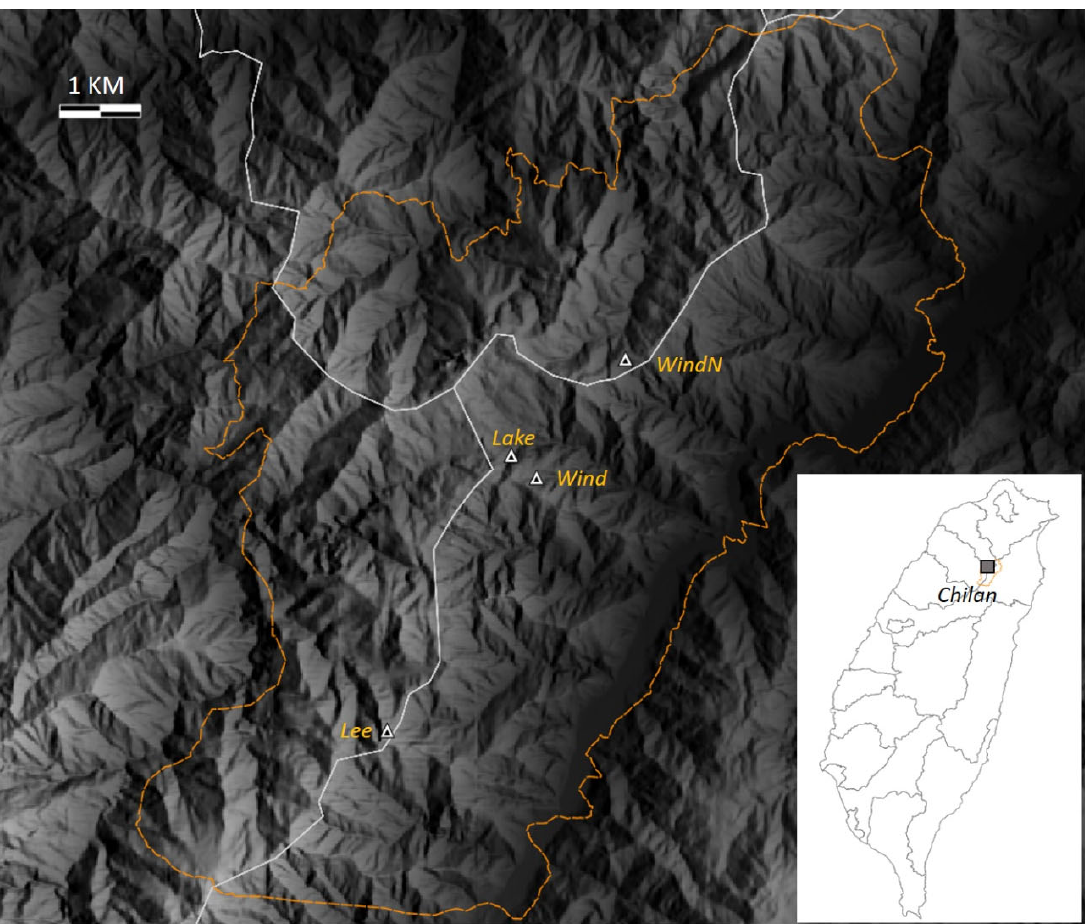
Figure 1. Location and altitude of the four sites in Chilan: Lake (1692 m), Lee (1883 m), Wind (1703 m), and WindN (1680 m). The two most distant sites, WindN and Lee, are about 10 km from each other. Orange boundary lines indicate the Chilan Reserve area, which straddles three counties (white lines).